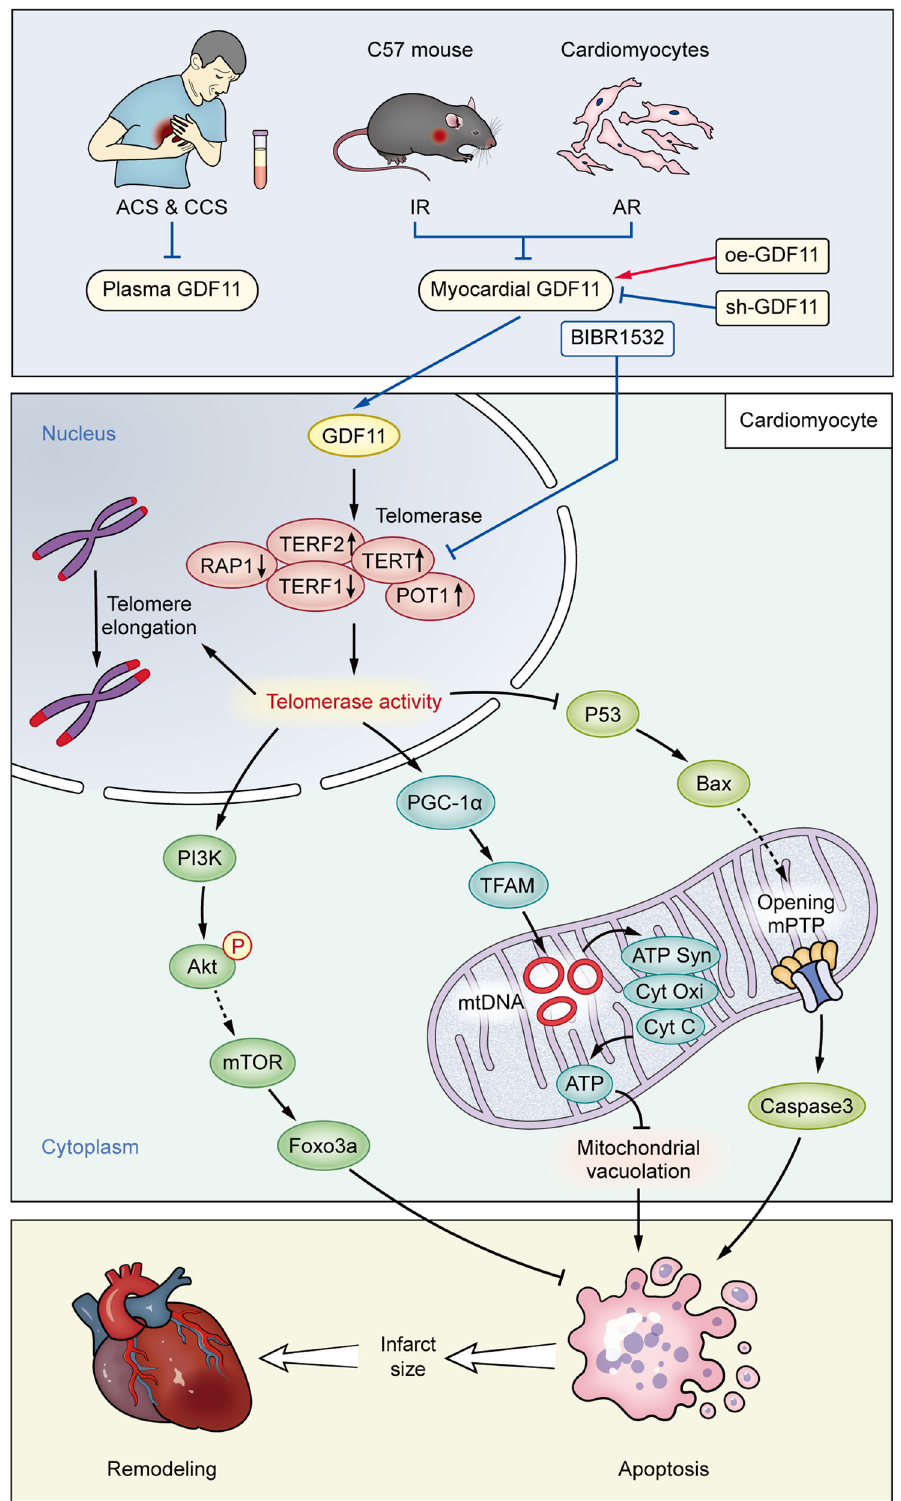
Fig. 8 An illustration of the in fl uences of GDF11 on IR/AR injury and the underlying mechanisms. Patients with CAD, especially ACS, and rodent cardiomyocytes subjected to IR or AR insult, exhibit lower circulatory or myocardial GDF11 levels, leading to lower activity of telomerase and shorter TL in the nucleus due to downregulation of TERT, inhibiting mitochondrial energy dynamics and the antiapoptotic PI3K/Akt/FoxO3a pathway and activating the proapoptotic p53/Bax pathway. These changes collectively increase cardiomyocyte apoptosis, enlarge the myocardial infarct size and eventually promote cardiac remodeling. The changes can be antagonized and enhanced by overexpression and silencing of GDF11, respectively, and the bene fi cial effects of GDF11 can be attenuated by the telomerase inhibitor BIBR1532. ↑ : activation, ⊥ : inhibition. ┆ : from other reference. │ : experimentally proven.